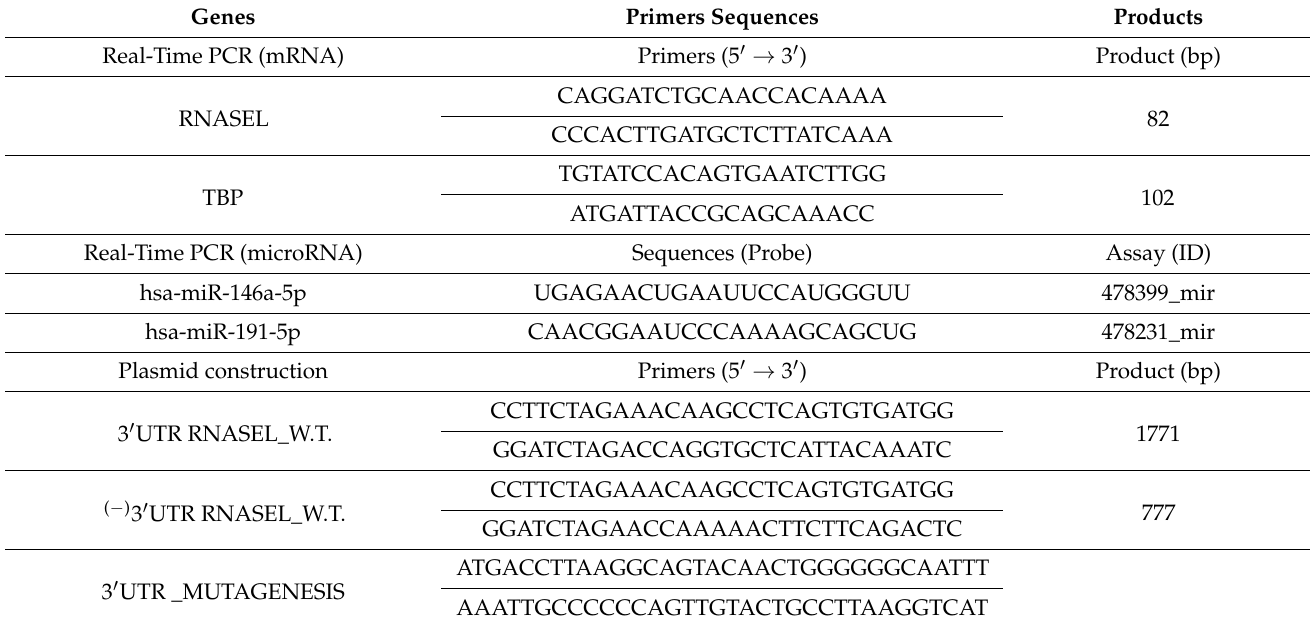
Table 1. Primers and probes used for Real-Time PCR and primers used for plasmid construction.